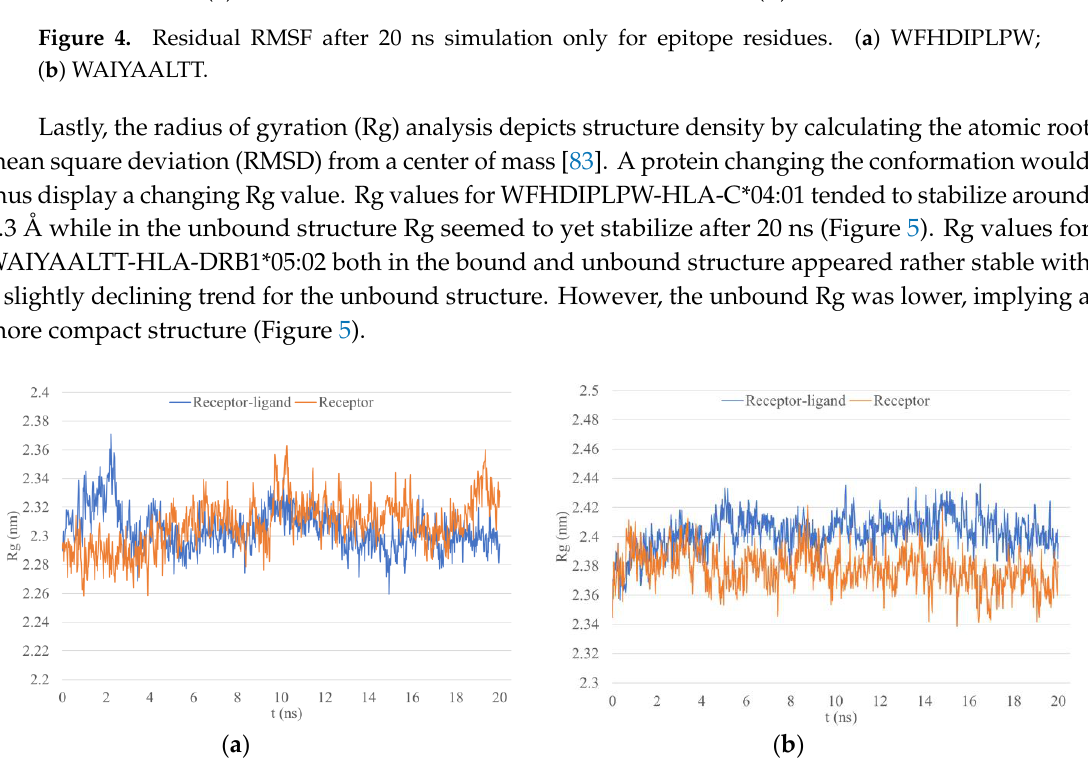
Figure 5. The radius of gyration (Rg) within 20 ns MD simulation. ( a ) Epitope WFHDIPLPW with HLA-C*04:01; ( b ) epitope WAIYAALTT with HLA-DRB1*15:02.